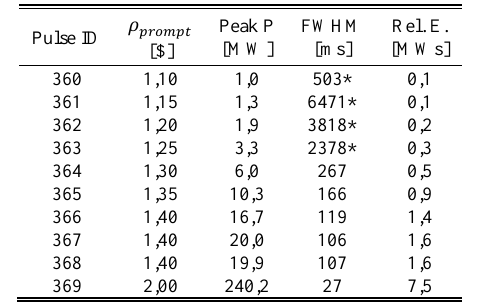
*FWHM values obtained from the TRIGA instrumentation for low peak power pulses are not